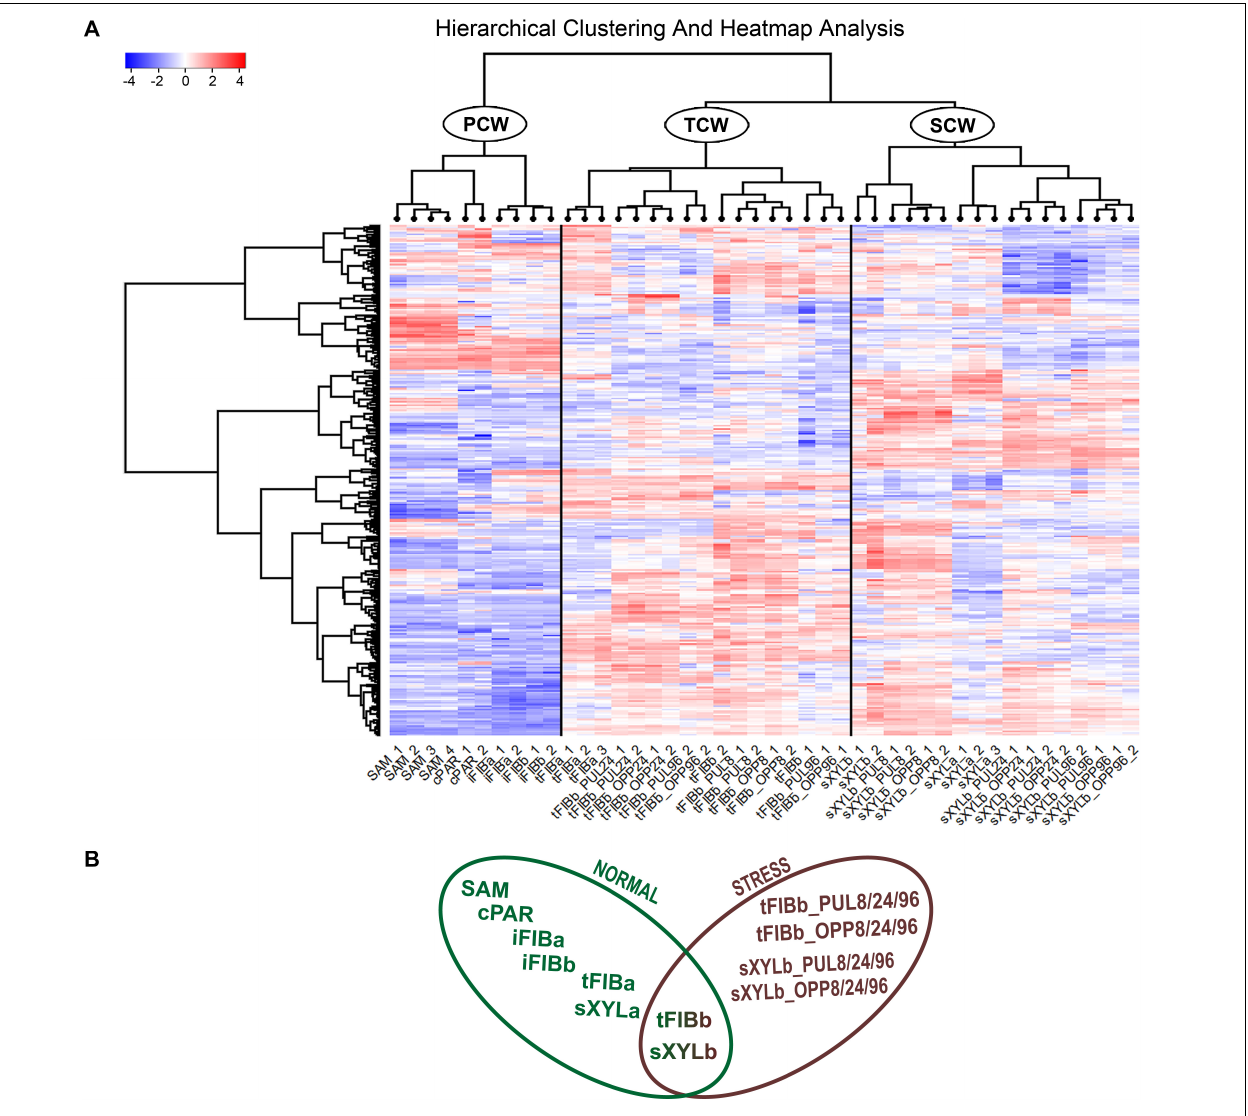
FIGURE 2 | Expression pattern of genes encoding proteins with lectin domains in all of the analyzed tissue samples collected from a flax stem (A) and datasets used in the analyses (B) . A heatmap with a dendrogram of hierarchical clustering is displayed in a grid where each row represents a gene ( n = 302) and each column represents a sample ( n = 44) with replicates. The color scale (–4 to 4) represents the Z–score, calculated by normalized expression values for lectin genes in different tissues (TGR ≥ 16 in at least one sample), where blue-white-red represents the genes with down–, unchanged, and upregulated expression, respectively. PCW, SCW, and TCW are the major clusters of samples (see text). Abbreviations: PCW, primary cell wall; SCW, secondary cell wall; and TCW, tertiary cell wall; tFIBb and sXYLb, isolated fibers with TCW and stem xylem with SCW of non-inclined plant, respectively; tFIBb_PUL8, tFIBb_PUL24, tFIBb_PUL96 – isolated fibers with TCW from pulling side of flax stem after 8, 24, 96 h of gravibending, respectively; tFIBb_OPP8, tFIBb_OPP24, tFIBb_OPP96 – isolated fibers with TCW from opposite side of flax stem after 8, 24, 96 h of gravibending, respectively; sXYLb_PUL8, sXYlb_PUL24, sXYLb_PUL96 – pulling side of stem xylem with SCW after 8, 24, 96 h